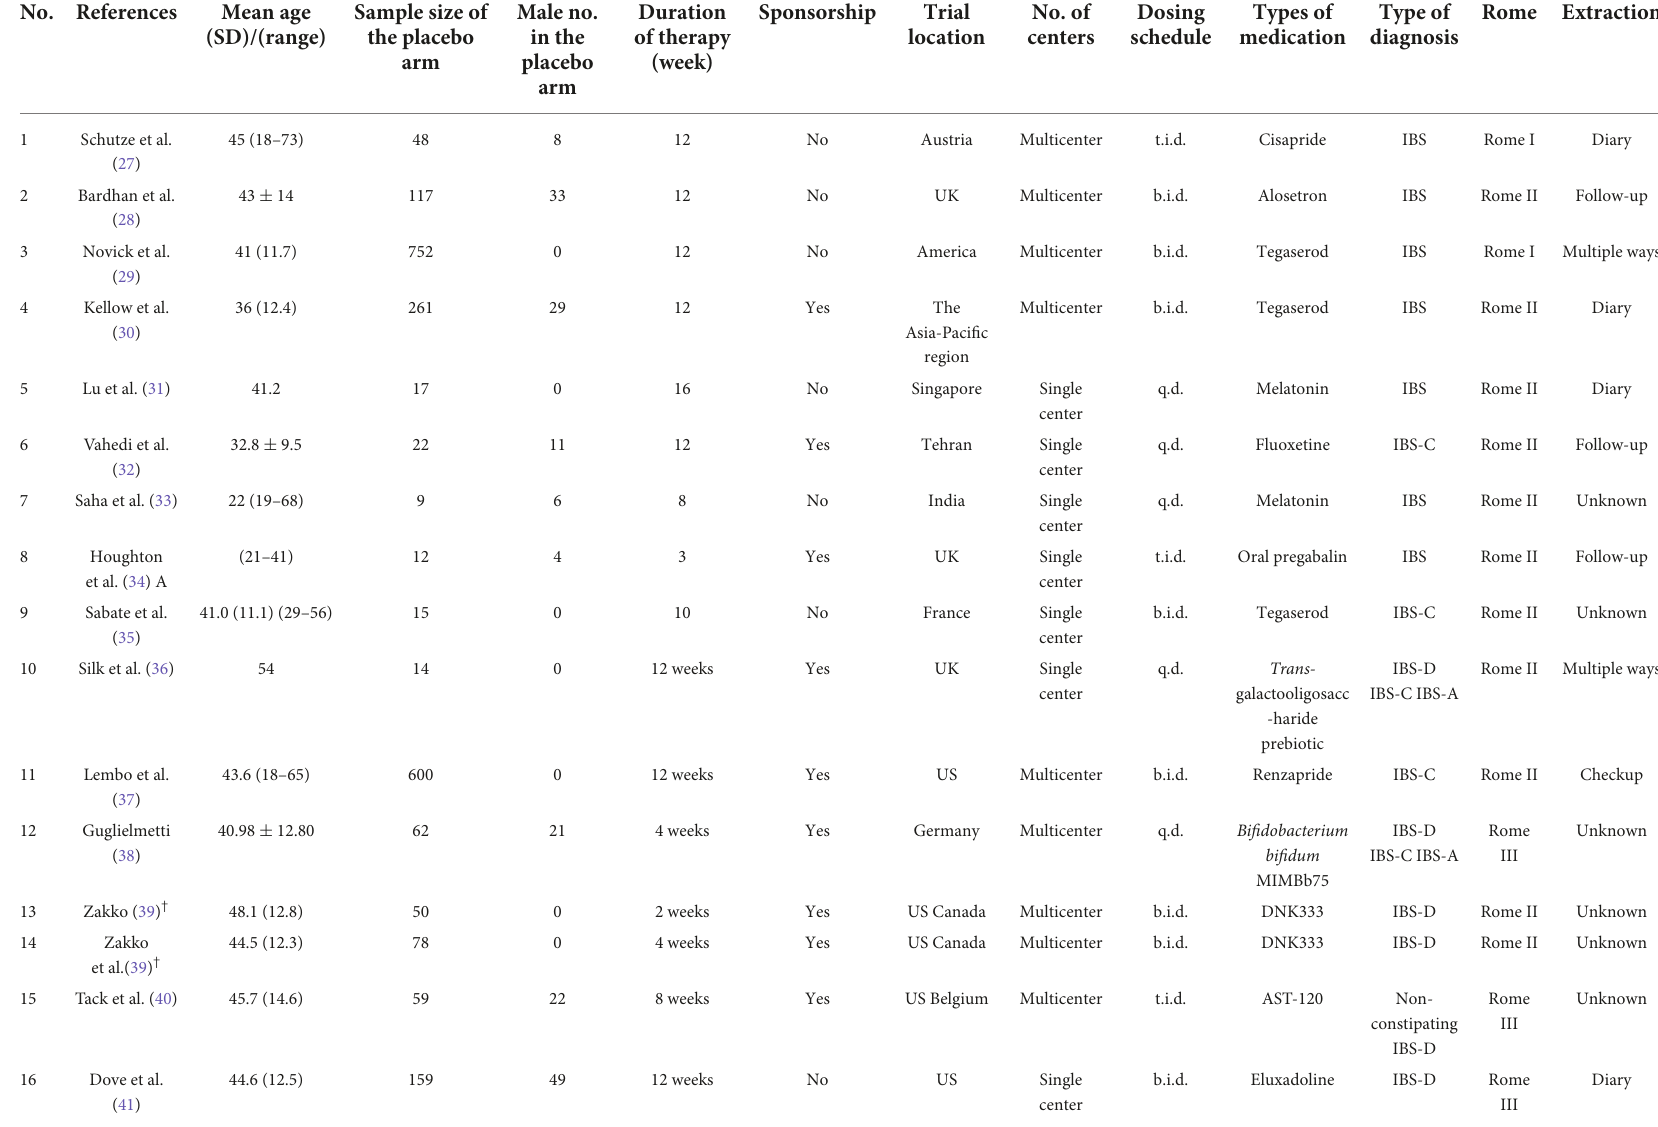
TABLE 1 Characteristics of 36